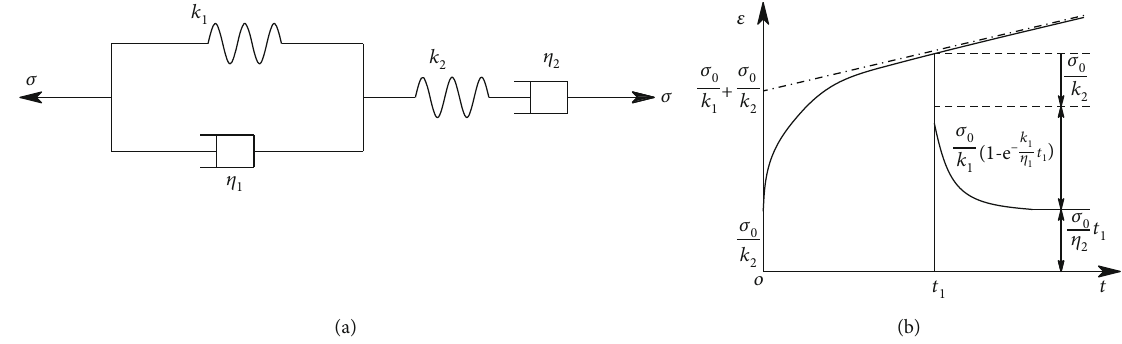
Figure 14: Burgers mechanic model and dynamics. (a) Burgers mechanics model. (b) Burgess creep and unload